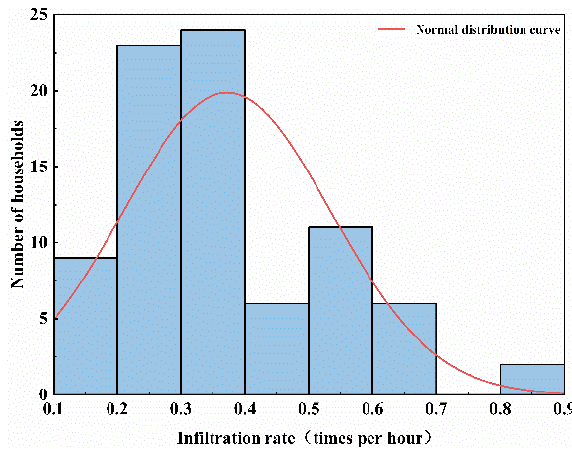
Figure 4. Distribution histogram of the infiltration rate.